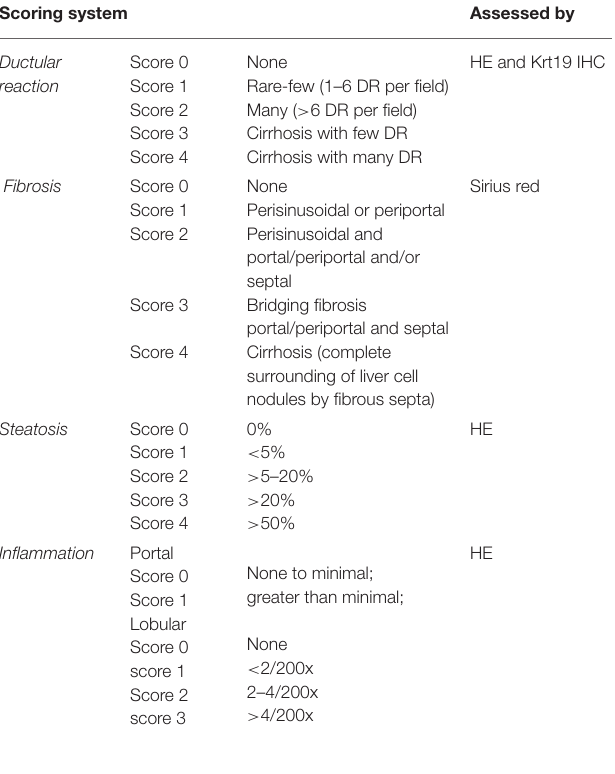
TABLE 2 | Primers used for PCR for amplicon sequencing of murine Spp1 . Ampli-con ID Genomic position (mm10) Primer forward (5 ′ -3 ′